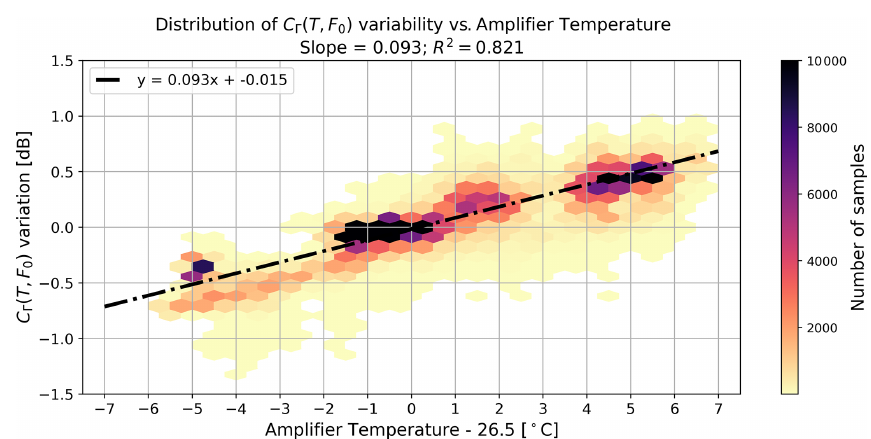
Figure 7. A 2D histogram of the relative changes in C (cid:48) (T,F 0 ) with respect to changes in the amplifier temperature and its linear least squares fit. The histogram is plotted using all C (cid:48) (T,F 0 ) samples from the 2018 and 2019 calibration